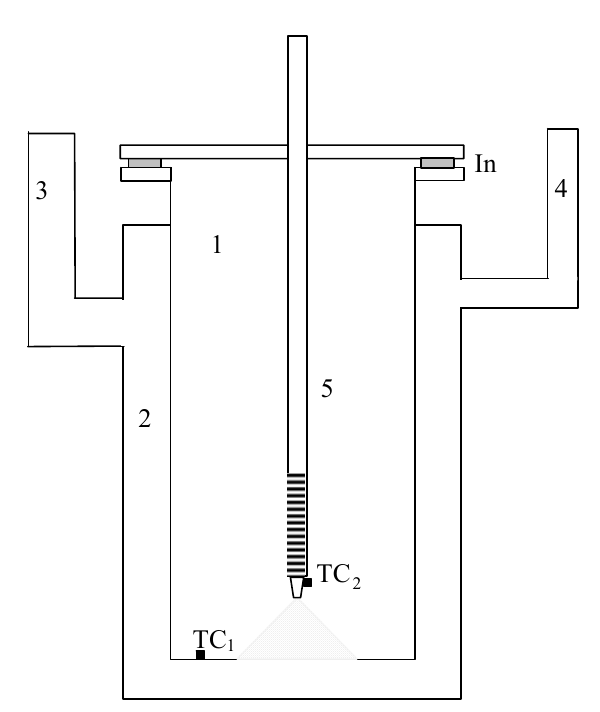
Fig. 3 A sketch of the stainless steel ozonization reactor. In – indium gasket, 1 - the inner volume, 2 - the outside volume filled with liquid nitrogen, 3 and 4 - tubes for filling and evaporating liquid nitrogen, 5 – the nozzle for inserting the reactants and removing the products.